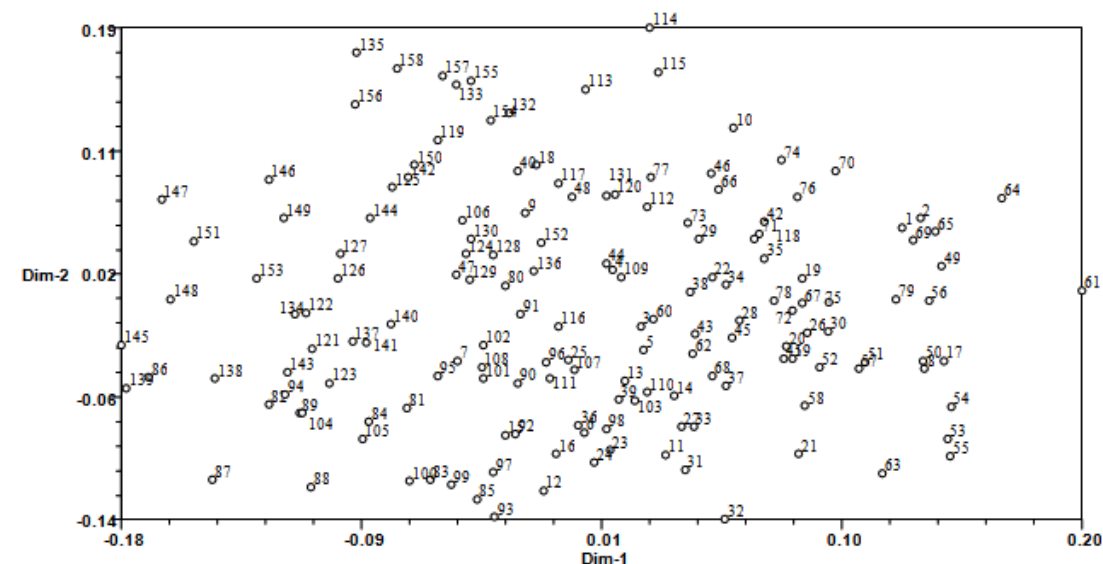
Fig. 2: Principal coordinate analysis diagram showing the relationships among 158 apple accessions (numbers of accessions were identifed in Tab.